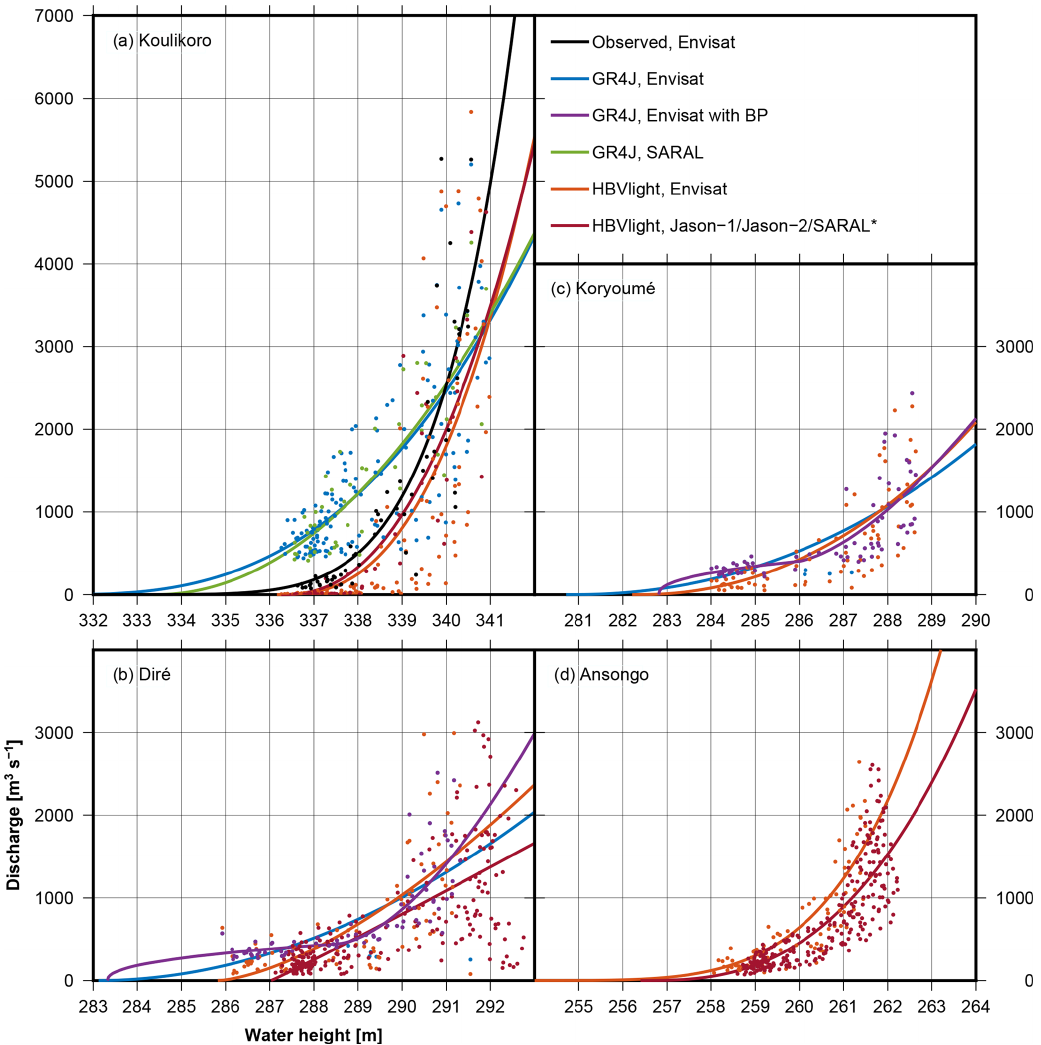
Figure 8. Rating curves for (a) Koulikoro, (b) Diré, (c) Koryoumé, and (d) Ansongo. The Kandadji station is omitted due to the insufficient amount of altimetry and discharge data. The points are the discharge values plotted against the altimetric water depth. The lines are the rating curves, which are fitted through the points. ∗ The red rating curves are created with SARAL/Altika data for Koulikoro, Jason-1 for Diré, and Jason-2 for